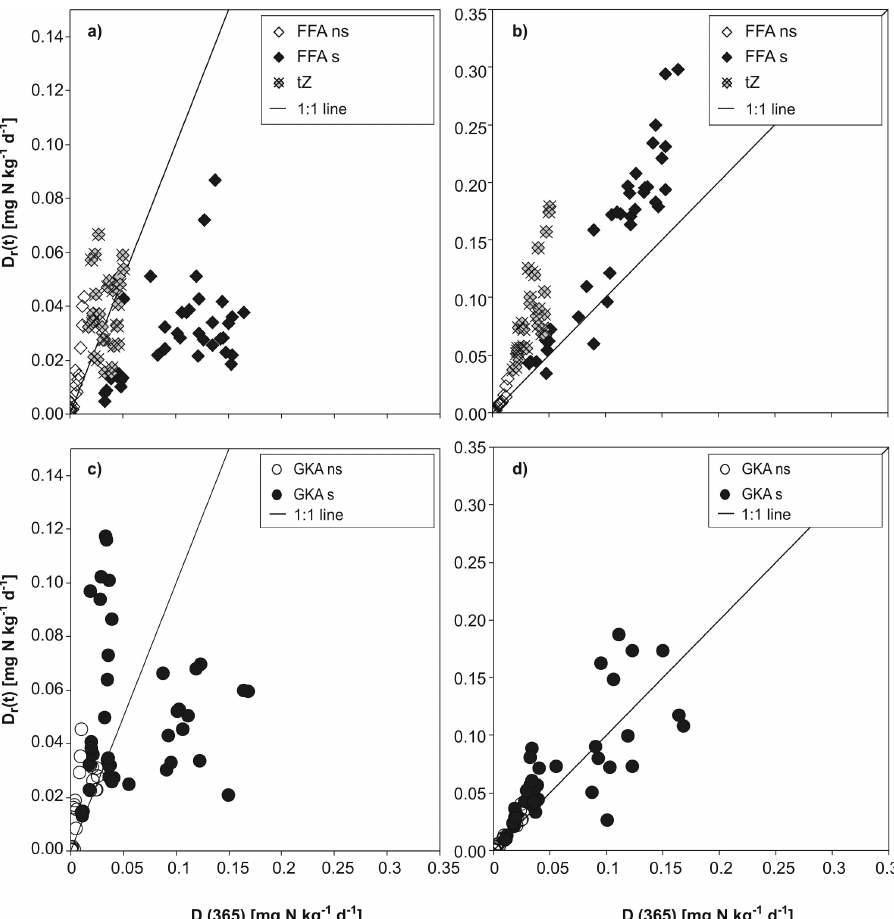
Fig. 3 Fig. 3. Relation between denitrification rates determined during 7 ( D r (7)), 84 ( D r (84)) and 365 ( D r (365)) days of incubation. (a) D r (7) vs. D r (365) of FFA samples. (b) D r (84) vs. D r (365) of FFA samples. (c) D r (7) vs. D r (365) of GKA samples. (d) D r (84) vs. D r (365) of GKA